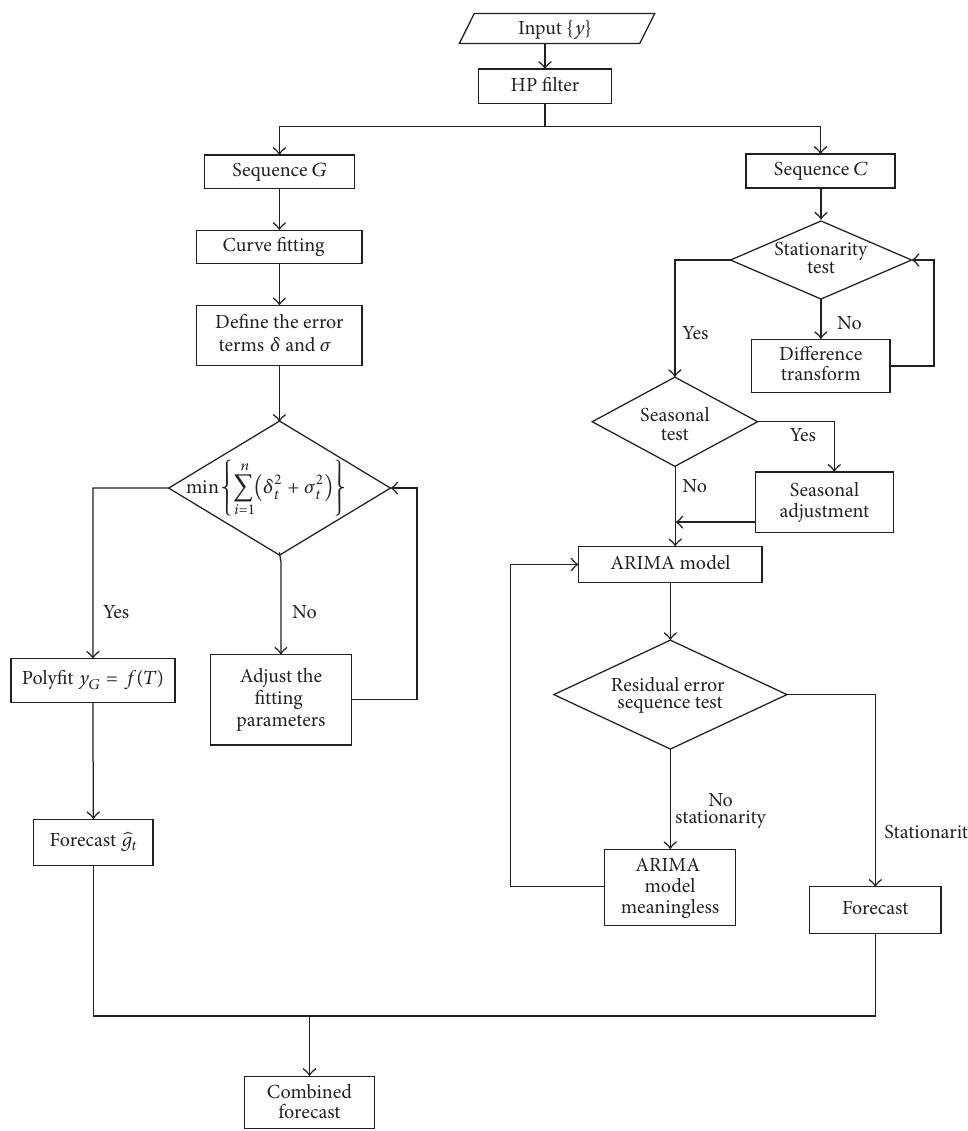
Figure 1: Model flow chart based on HP filter.